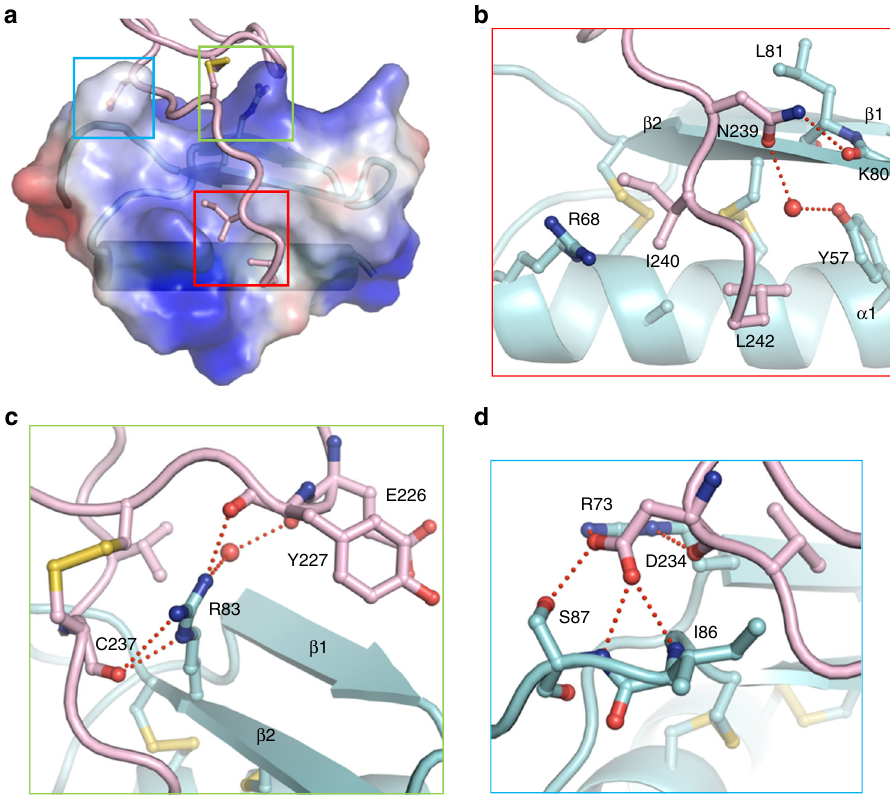
Fig. 3 Recognition mechanism of AtLURE1.2 by AtPRK6 LRR . a A close-up view of binding of the C-terminal side from AtPRK6 LRR to a positively charged surface of AtLURE1.2. AtLURE1.2 is shown in transparent electrostatic surface. Some of the critical amino acids from AtPRK6 LRR and AtLURE1.2 are shown in stick. Squares in three different colors indicate the interfaces between AtPRK6 LRR and AtLURE1.2. b The C-terminal side of AtPRK6 LRR binds to a hydrophobic cavity formed between the α -helix and the second β -sheet of AtLURE1.2. Red lines indicate hydrogen bonds. The red sphere represents water molecule. c Arg83 of AtLURE1.2 is at the center of the AtLURE1.2-AtPRK6 LRR interface and form extensive interactions with AtPRK6 LRR . d A network of polar interactions is formed between Asp234 of AtPRK6 and